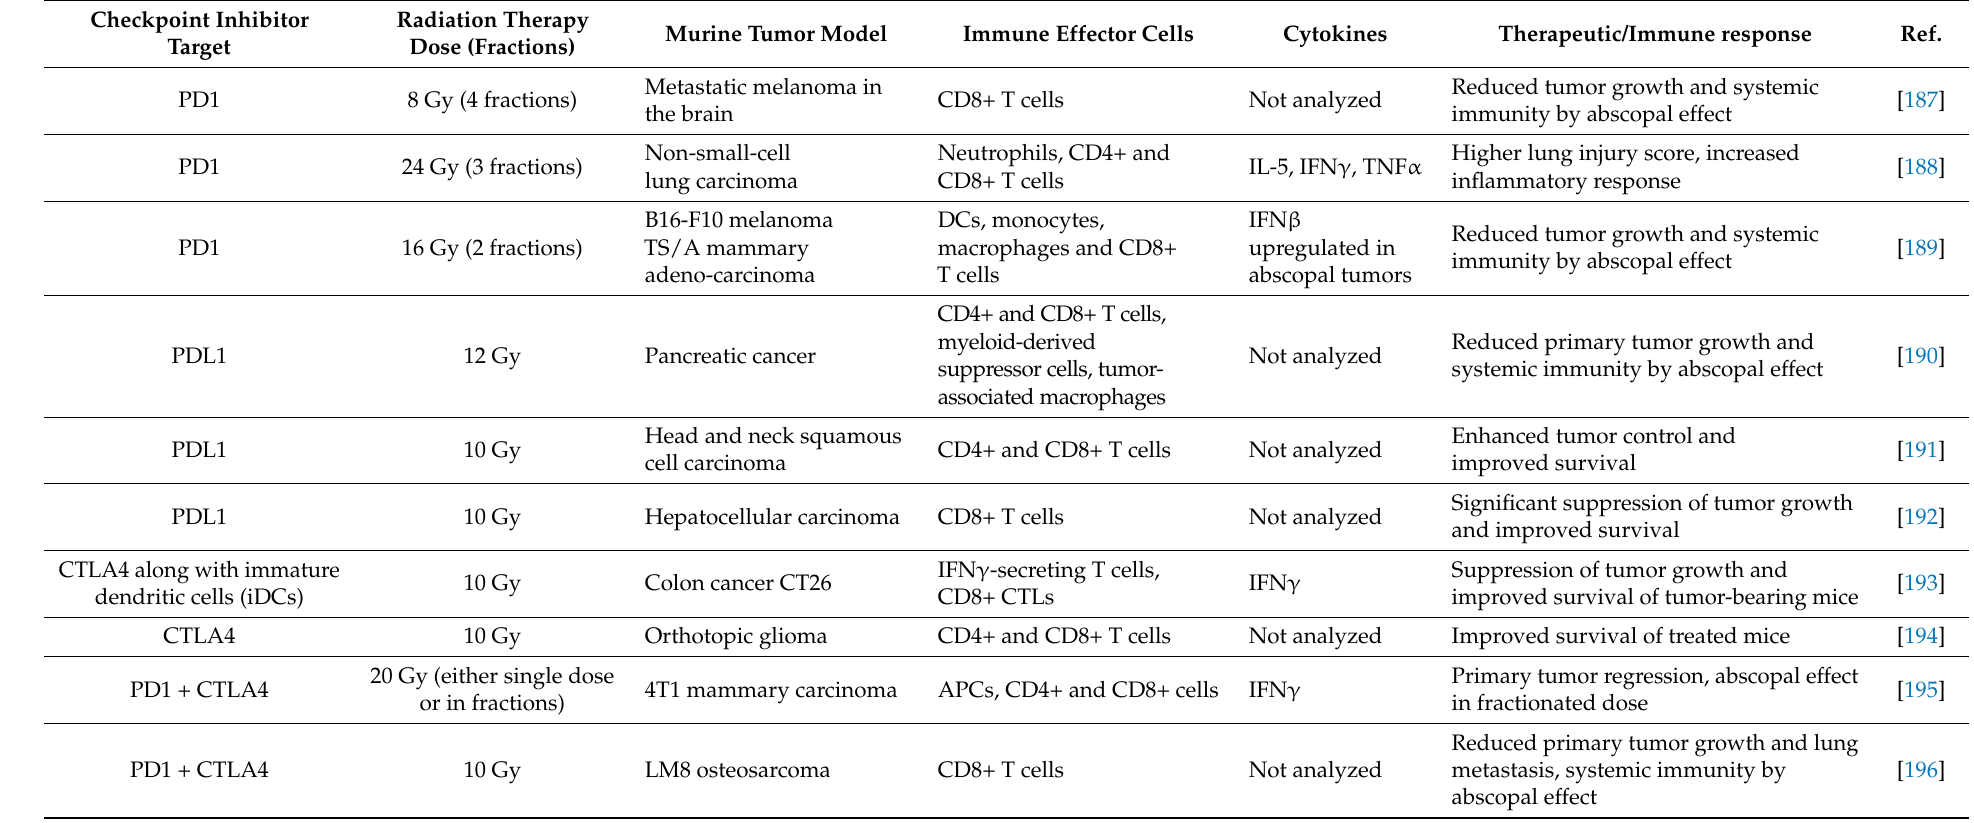
Table 3. A list of selected pre-clinical studies using combinations of immune checkpoint inhibition and radiation